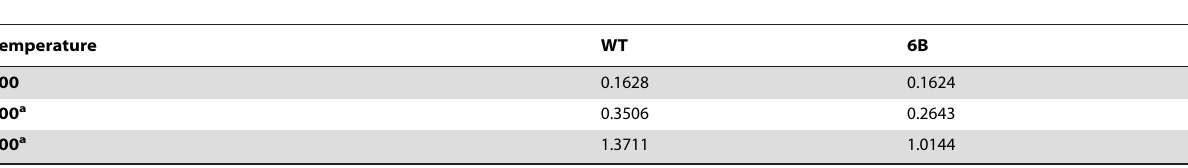
Table 3. Average RMSD values (nm) at different temperatures.